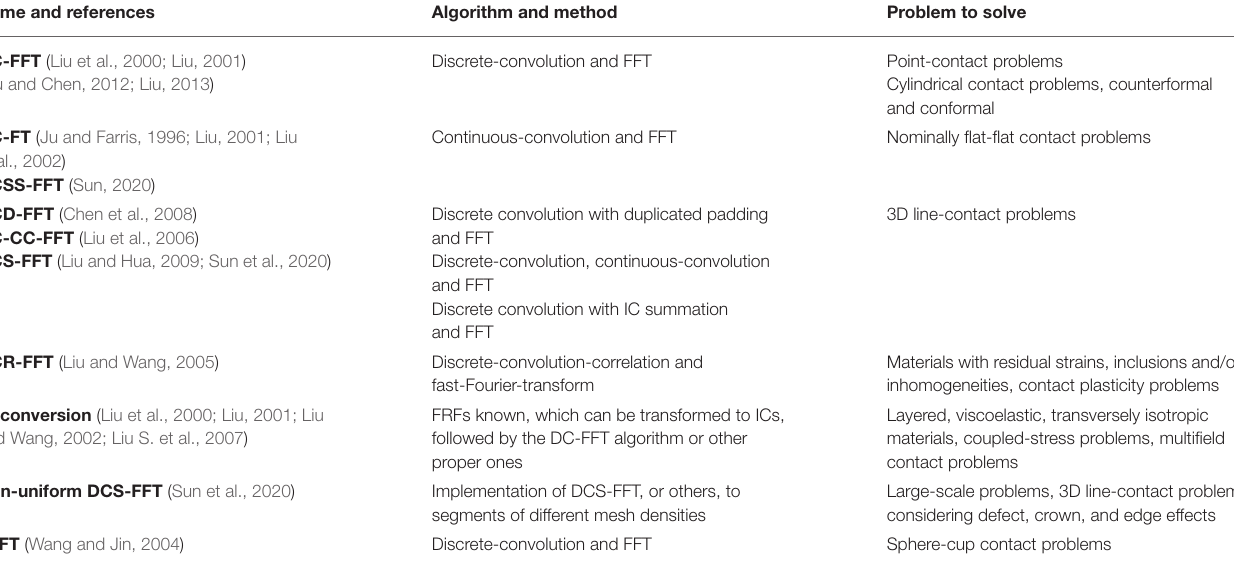
TABLE 1 | FFT methods for contact